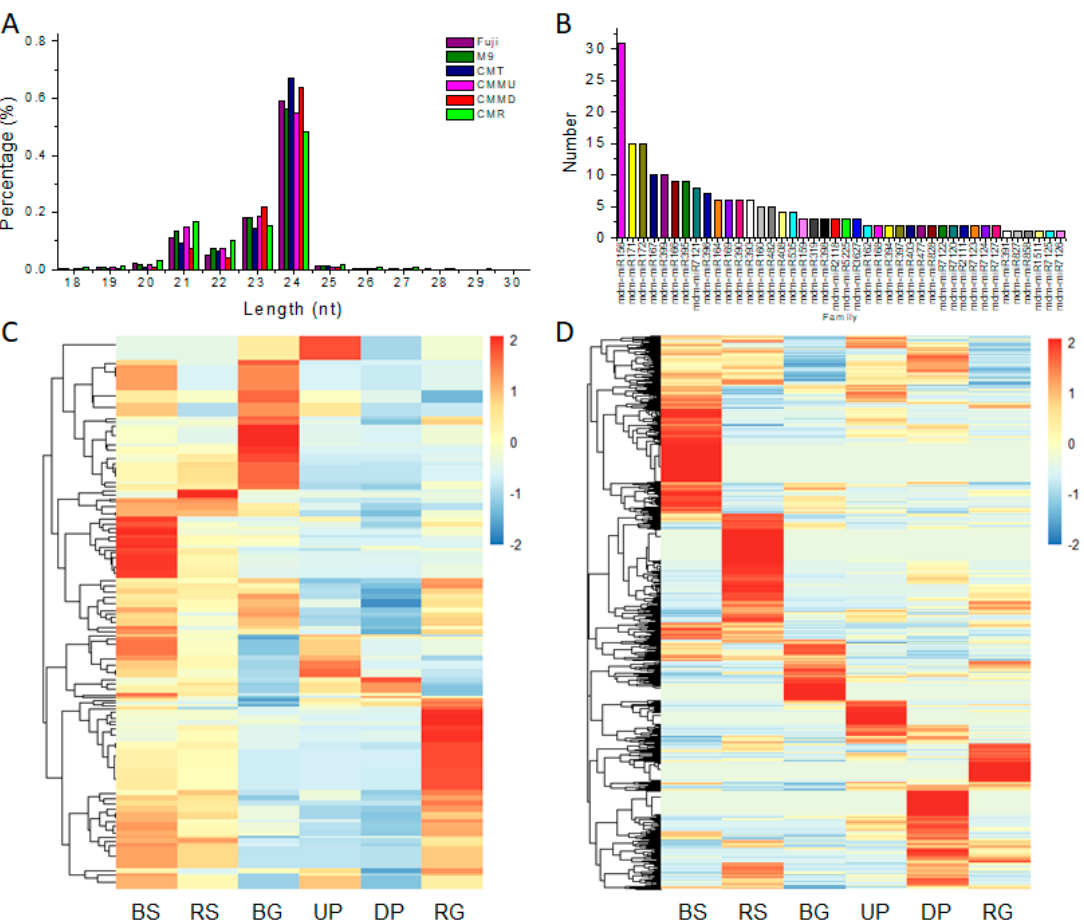
Figure 4. Overview of miRNAs in different apple trees. ( A ) Length distribution of identified miRNAs; ( B ) numbers of identified miRNAs in known miRNA families; ( C ) hierarchical clustering of identified known miRNAs; ( D ) hierarchical clustering of identified novel miRNAs. Branch tips of self-rooted Fuji (BS), root tips of self-rooted M9 (RS), branch tips of grafted Fuji/M9 (BG), root tips of grafted Fuji/M9 (RG), phloem of 10 cm above the graft union in Fuji/M9 (UP), phloem of 10 cm below the graft union in Fuji/M9 (DP).